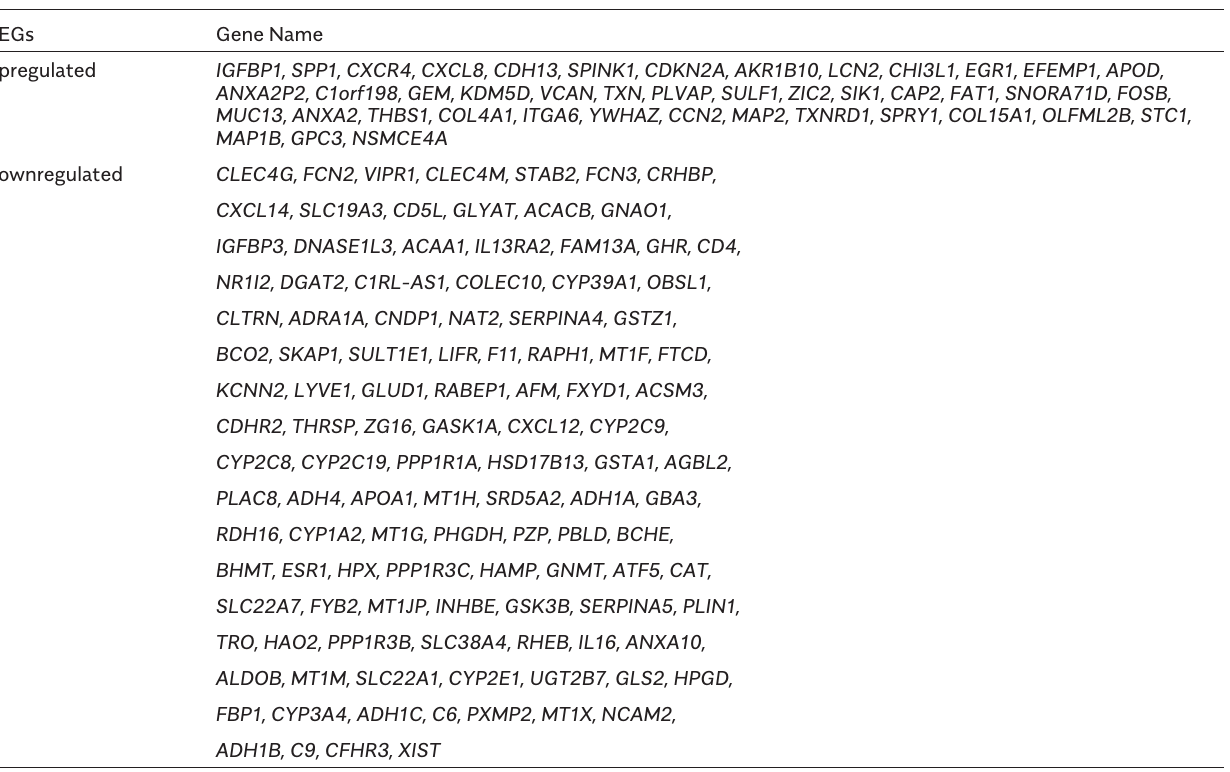
Table 1. DEGs in NASH-HCC Samples Compared with NASH Samples DEGs Gene